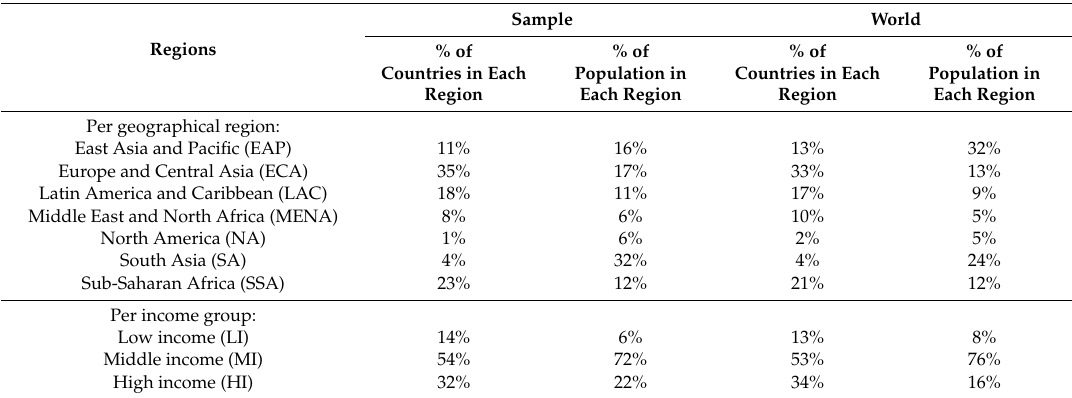
Table 1. Representativeness of the